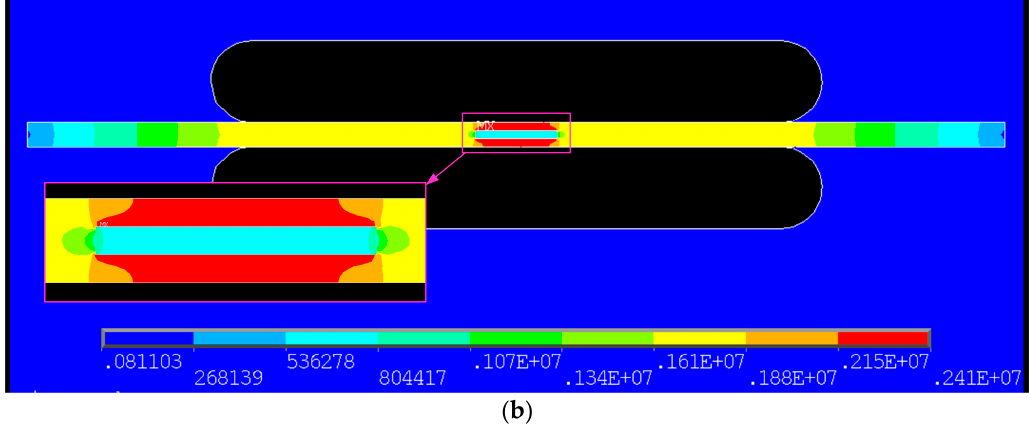
Figure 10. Electric field distribution of air gap model under AC and DC voltage components. ( a ) AC voltage component; ( b ) DC voltage component.